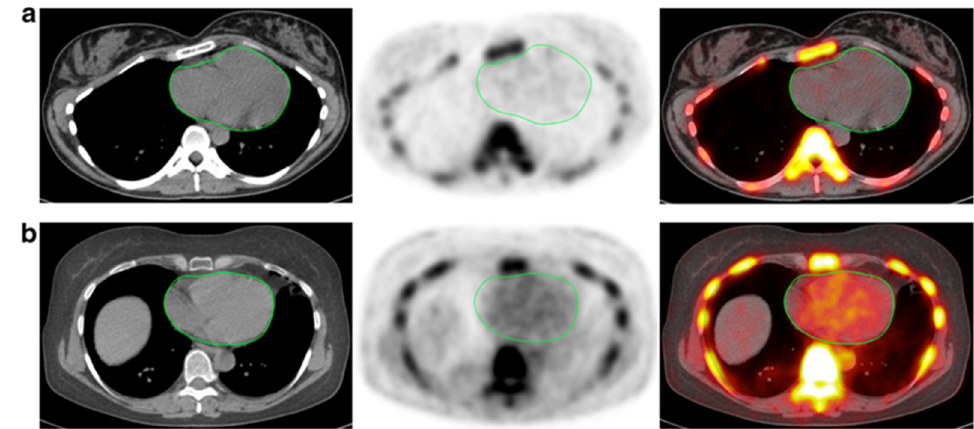
Figure 2. CT, NaF-PET, and fused NaF-PET/CT images of clinically normal ( a ) 25- and ( b ) 61-year -old subjects’ hearts. Green line delineates the region of interest around the heart analyzed to calculate the global cardiac calcification scores, which are 12,492.44 ( a ) and 18,424.70 ( b ). Despite the relatively increased NaF uptake in the PET scan of the subject’s heart ( b ), there is no visible calcification in the corresponding CT scan. The disparity between two modalities alludes to CT-visible macrocalcification as end-stage disease process, while NaF uptake may reflect early pathological, molecular changes (from Raynor et al. [94] with permission).